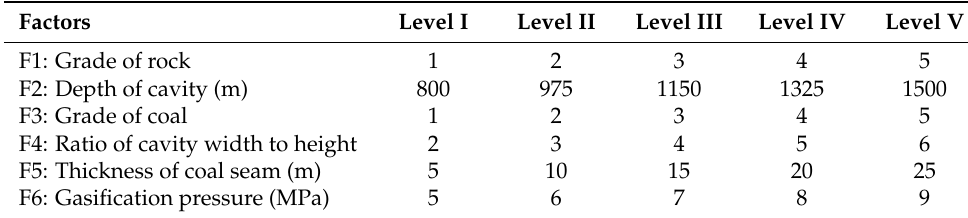
Table 1. Influence factors and their levels.